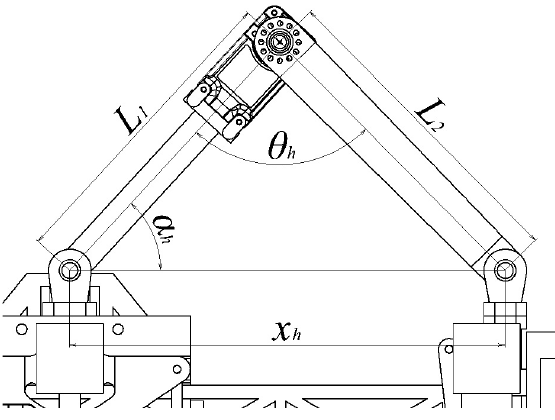
Figure 9. Parameters definition for the linear actuator in the horizontal